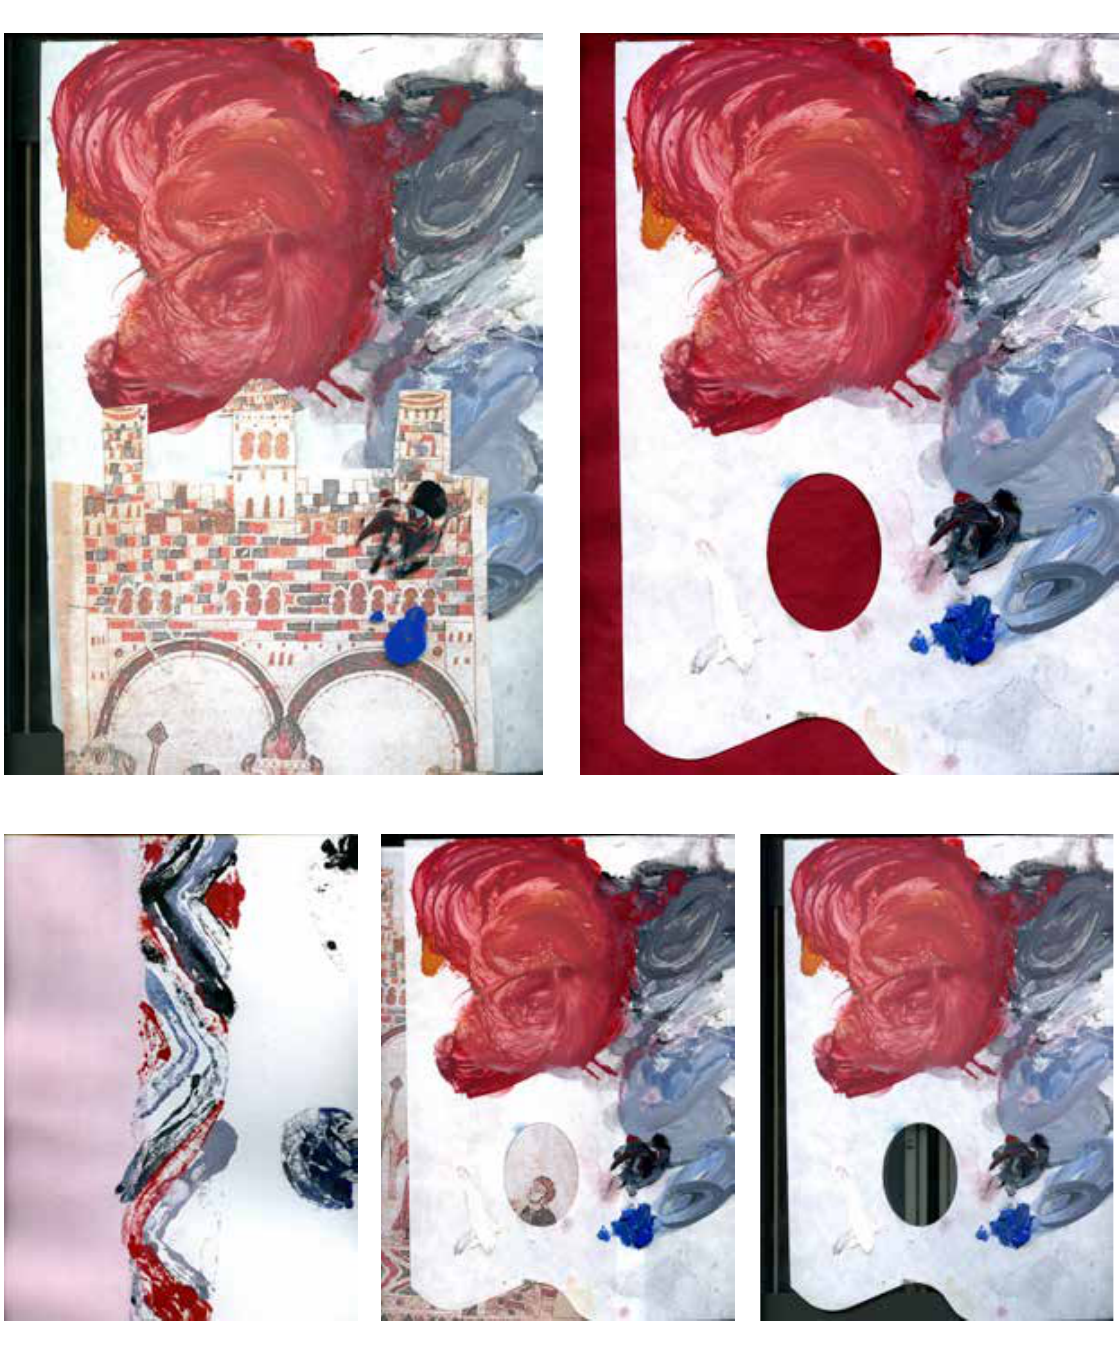
Figures 4–8: Barbara Ellmerer, 2018. Image Finding, BE IP1. Source: Nils